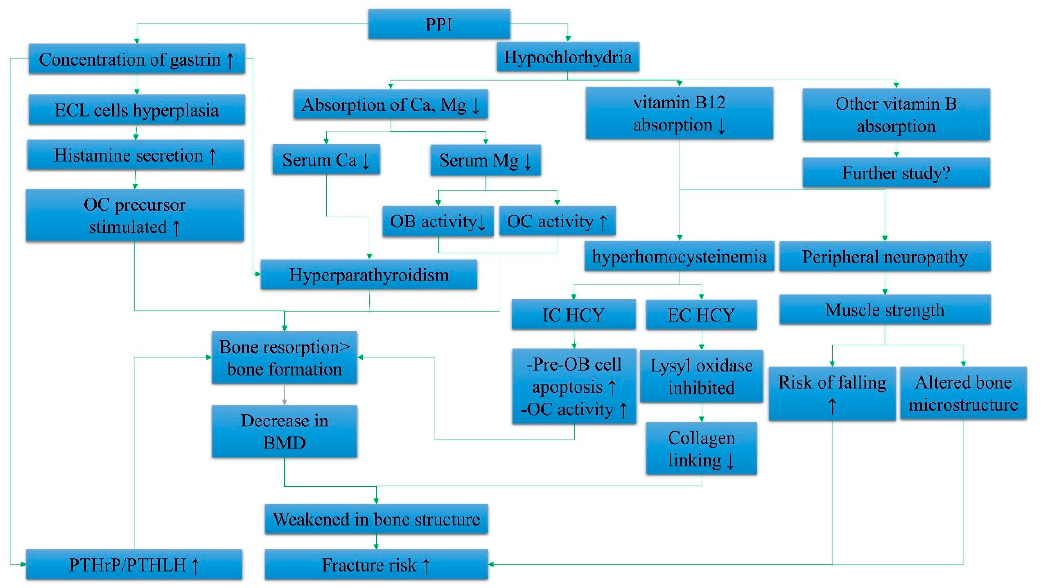
Figure 1. Summary of the systemic effects of proton pump inhibitors (PPIs) in elevating fracture risk. Abbreviations: IC HCY, intracellular homocysteine; EC HCY, extracellular homocysteine; ECL cells, enterochromaffin-like cells; Ca, calcium; Mg, magnesium; BMD, bone mineral density; PTHrP, parathyroid hormone-related peptide; PTHLH, parathyroid hormone-like hormone; OB, osteoblast; OC, osteoclast; ↑ , increase; ↓ , decrease.